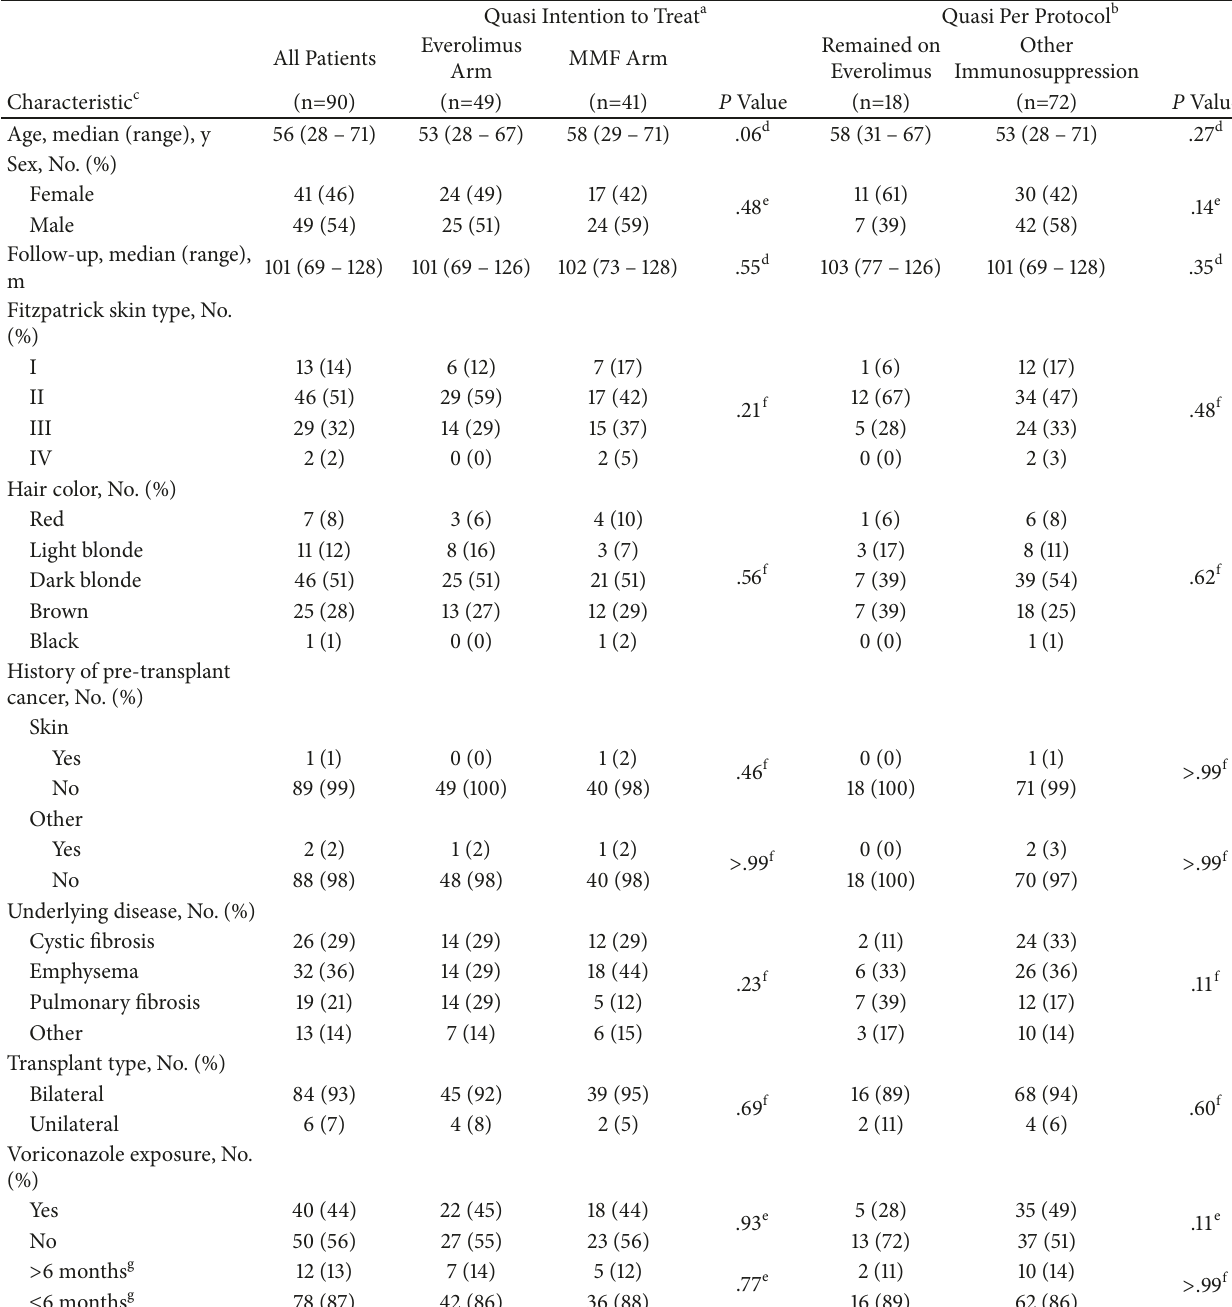
Table 1: Patient demographic